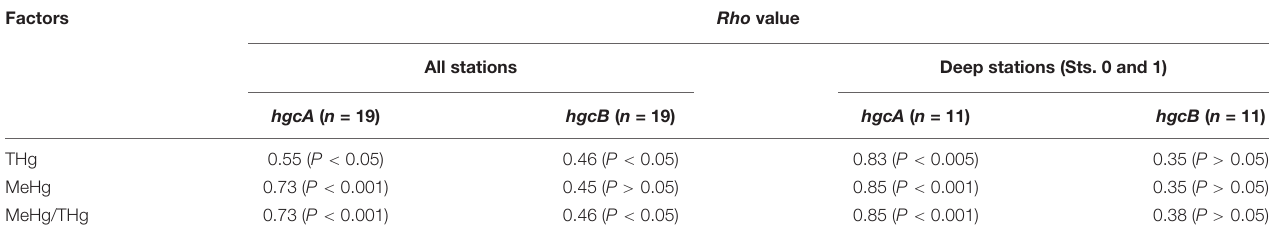
TABLE 3 | Spearman’s rank correlation analysis of mercury species and abundance of hgcAB -like sequences at all stations and at deep stations (Sts. 0 and 1). Factors Rho value All